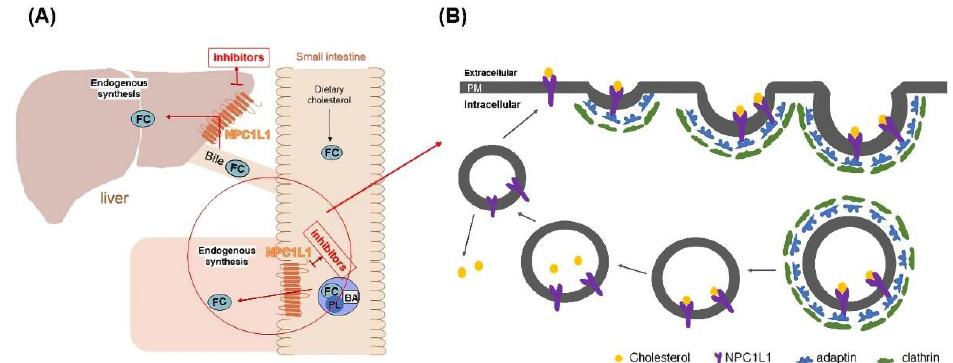
Figure 1. ( A ) Schematic diagram of the mechanism of NPC1L1 in small intestine and liver choles- terol transport. ( B ) Schematic diagram of NPC1L1-mediated cholesterol uptake process. (PL) phos- pholipids, (BA) bile acids, (FC) free cholesterol, and (PM) plasma membrane.